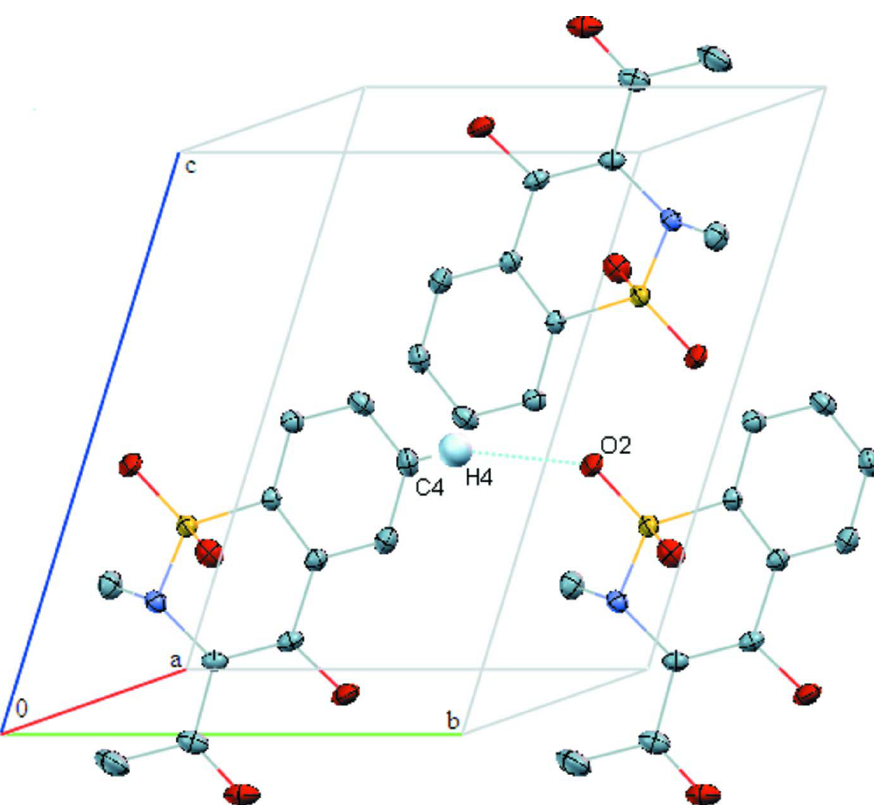
Figure 2 Unit cell packing of (I), showing intermolecular H-bonds resulting in the chains of molecules lying along the b axis; H atoms not involved in H-bonding have been